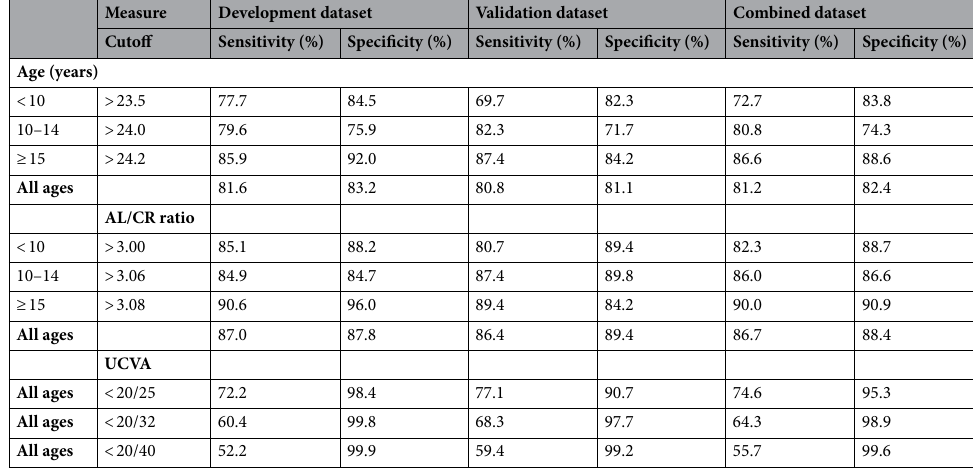
Table 6. Sensitivity and specificity for detecting myopia using single ocular biometrics or uncorrected visual acuity in the development dataset and validation dataset. AL axial length, AL/CR ratio axial length/corneal curvature radius ratio, UCVA uncorrected visual acuity.